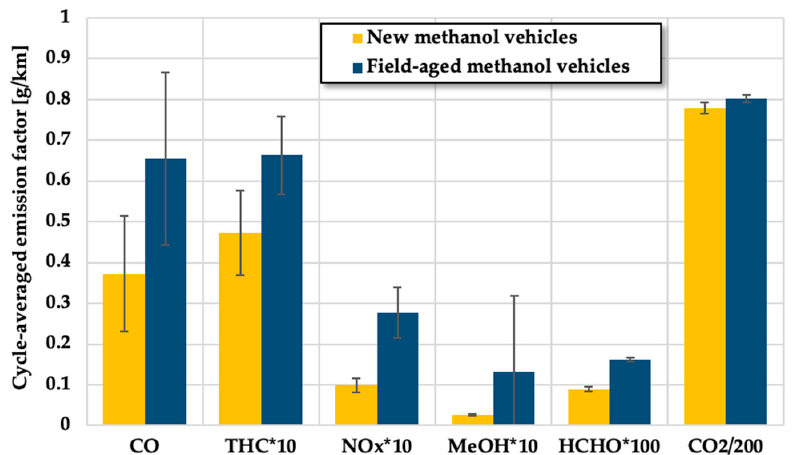
Figure 9. Comparison between the emission factors of the in-use and new methanol taxis.